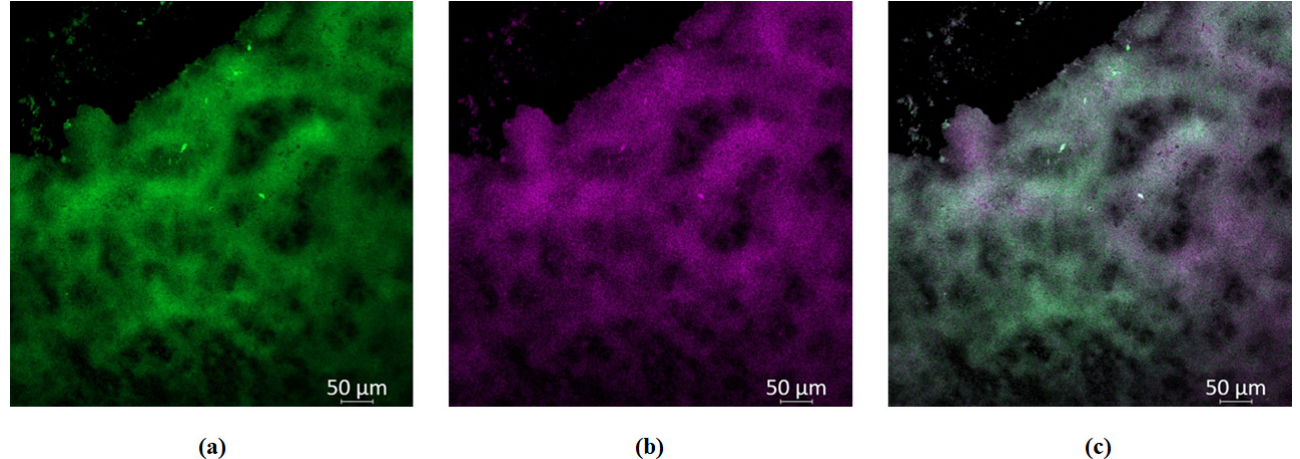
Figure 3. Confocal images of S. aureus biofilms showing wide distribution of GaPP within biofilms. ( a ) green channel showing viable S. aureus within biofilms stained with Syto-9 at 525 nm, ( b ) violet channel showing GaPP fluorescent signal at 585 nm, ( c ) mixed channel showing the distribution of GaPP within biofilms. The decline in Syto-9 fluorescent signal is attributed to the reduction in viability due to GaPP antibacterial activity.